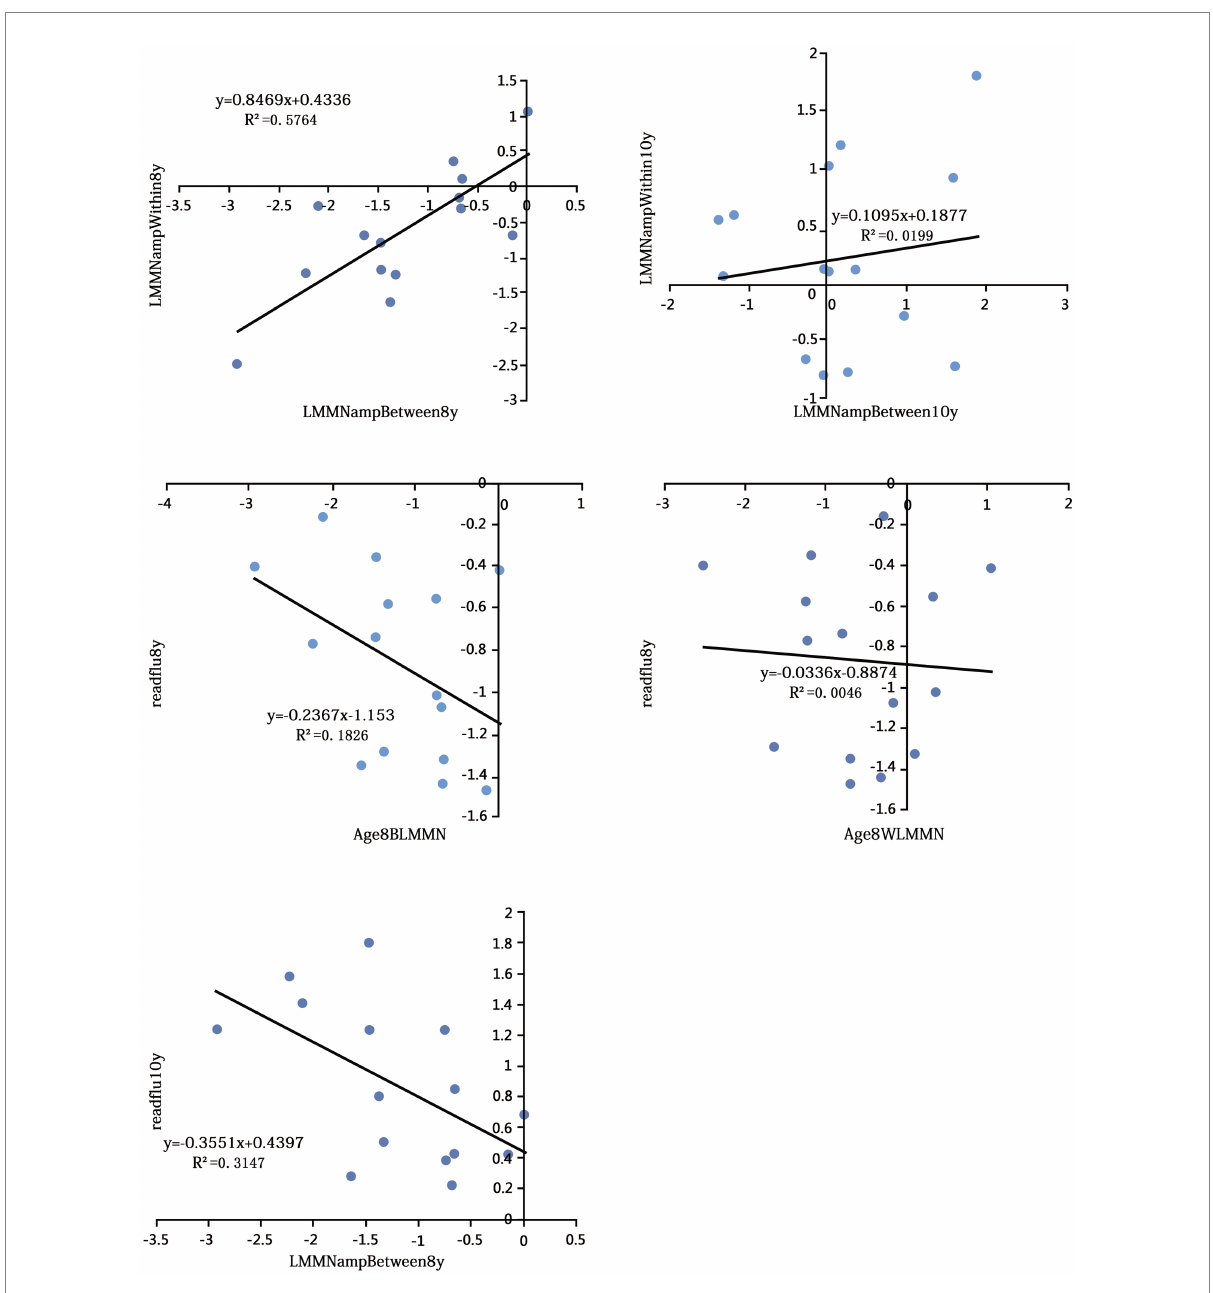
FIGURE 2 Scatter plots display the relationship between MMN amplitude values and reading